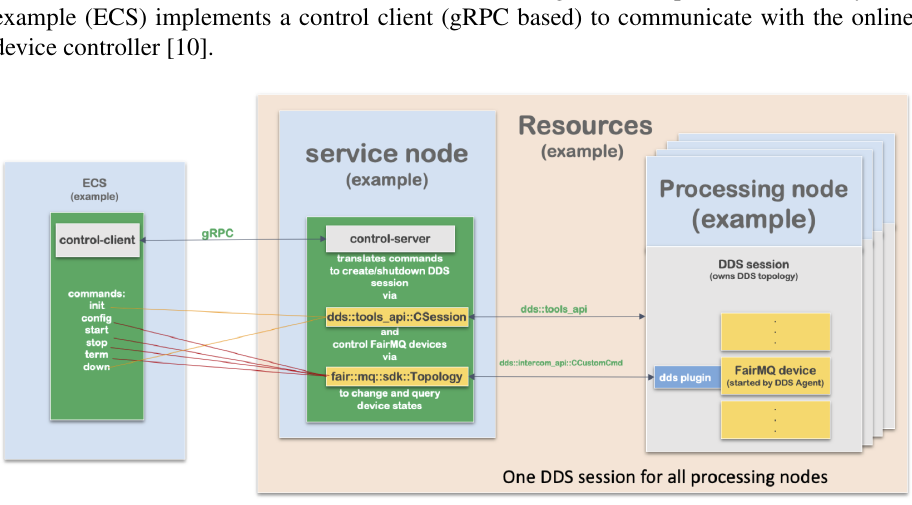
Figure 1. DDS based processing control